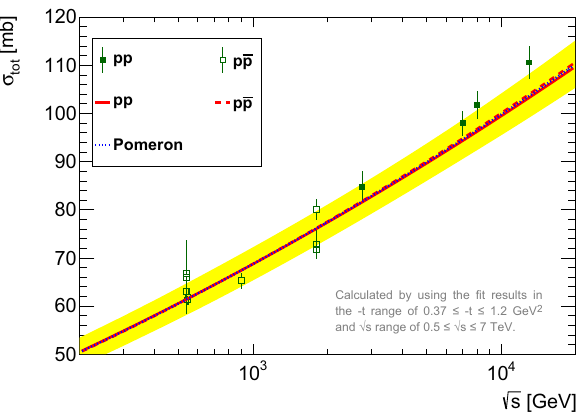
Fig. 27 Excitation function of the total cross-section for elastic pp , p ¯ p collisions and for the amplitude of Pomeron exchange, as evalu- ated from the log-linear excitation functions of the opacity parameters α pp ( s ) and α p ¯ p ( s ) as well as that of the scale parameters, R R qd ( s ) , corresponding to Table 2. The yellow band indicates our con- servative estimates on the systematic errors of the total cross-section of the Pomeron